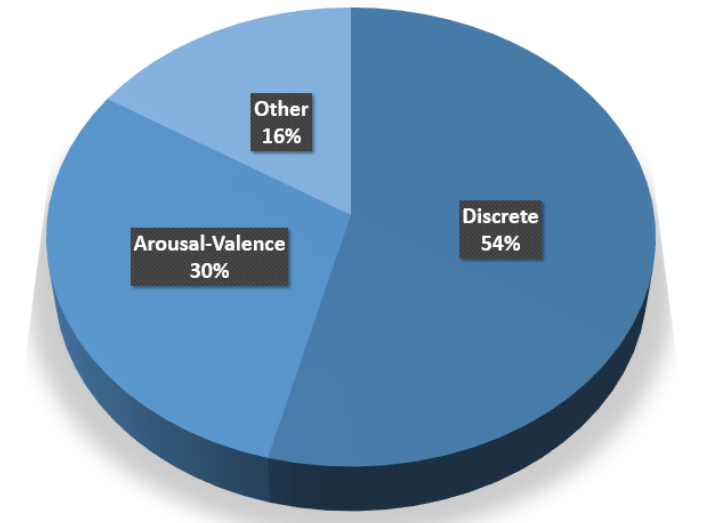
Figure 4. Used emotional model for recognition